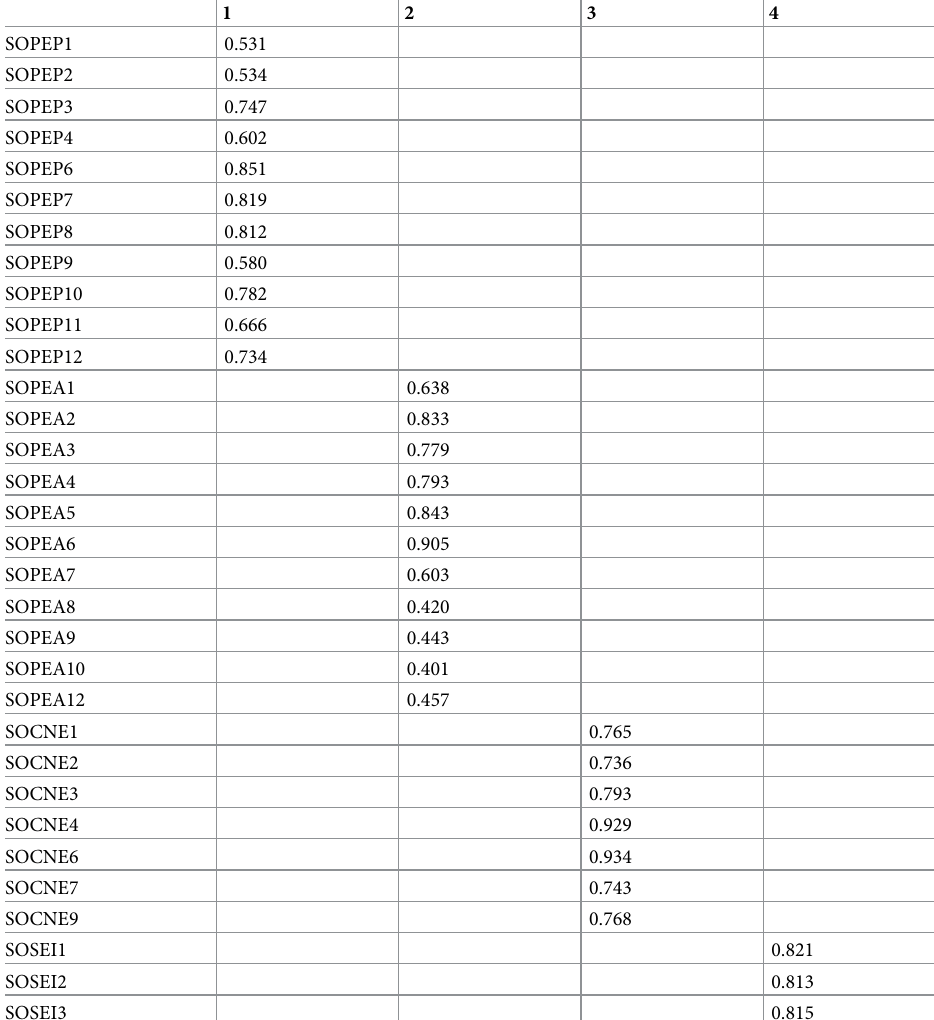
Table 4. Pattern Matrix- Exploratory Factor Analysis